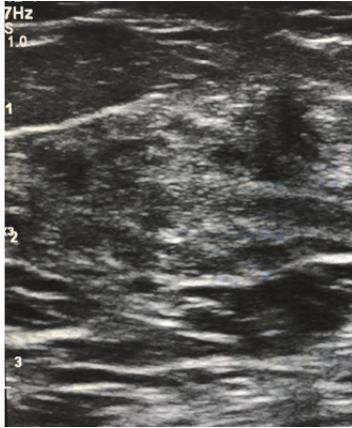
Figure 3: Proliferative changes in the accessory breast tissue in the axillary region. There is no evidence of mass